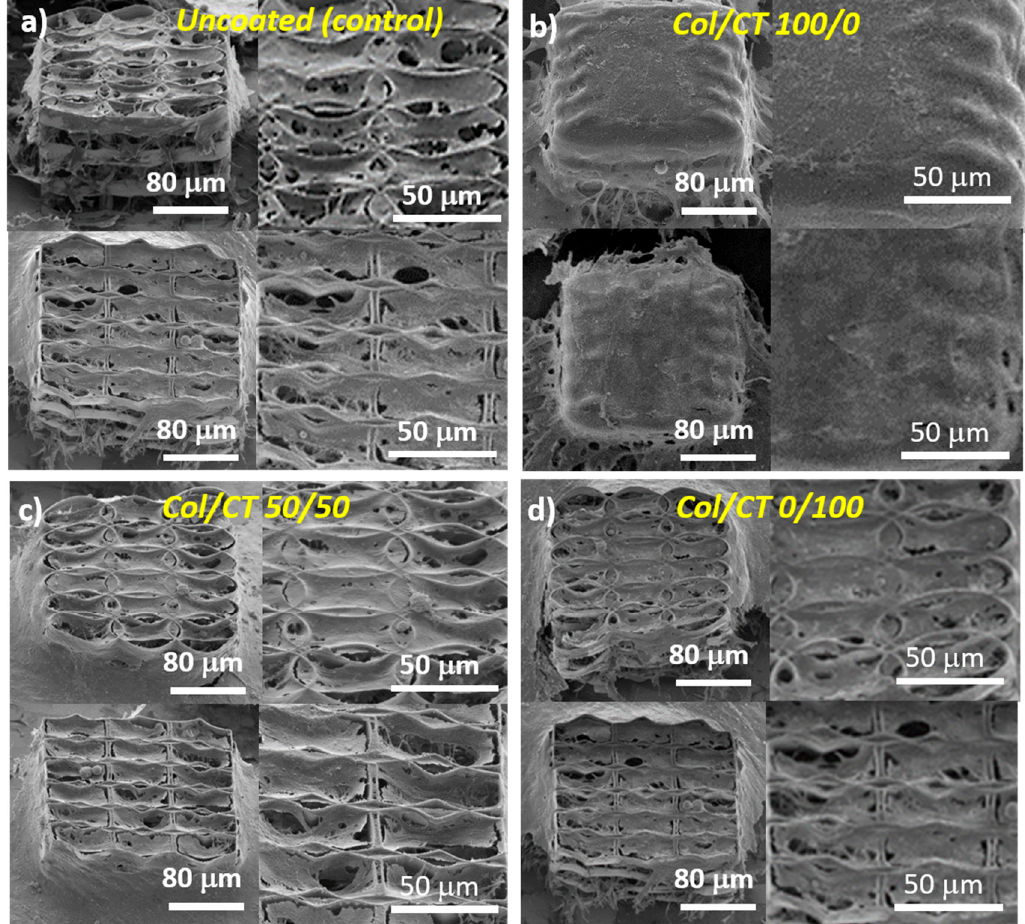
Figure 3. SEM micrographs of MG-63 osteoblast-like cells seeded for 3 days on: ( a ) uncoated 3D structures; ( b – d ): 3D structures functionalized with Col/CT with different blending ratios. For ( a – d ): the upper panels illustrate cells seeded on structures with ellipsoidal units; the lower panels illustrate cells seeded on structures with hexagonal units; the left panels show overviews of cell-seeded structures tilted with 30°; the right panels show closer views of cell-seeded structures depicted in the left panels.